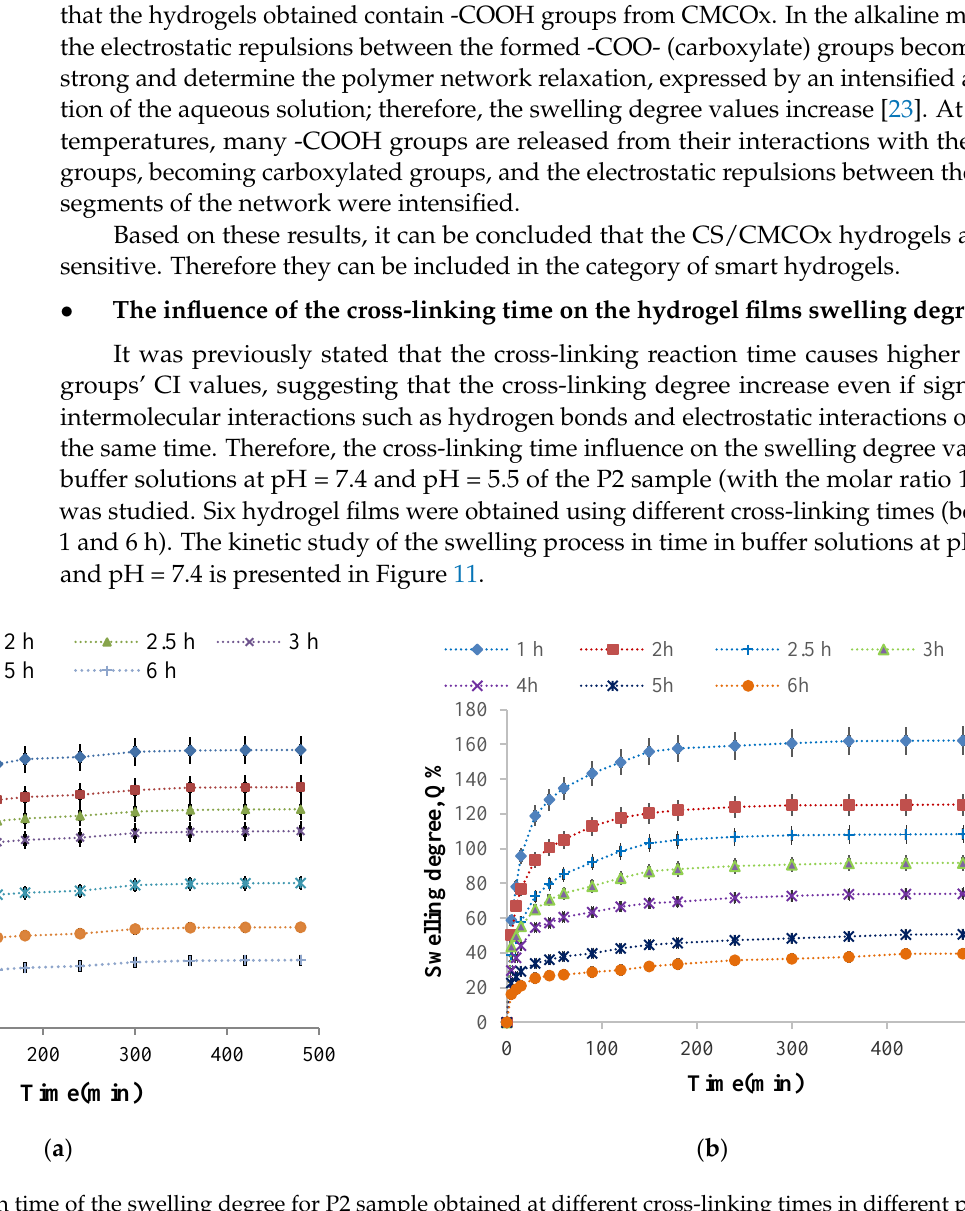
Figure 12. Curcumin encapsulation efficiency in CS/CMCOx films obtained at different CHO: NH 2 molar ratios.